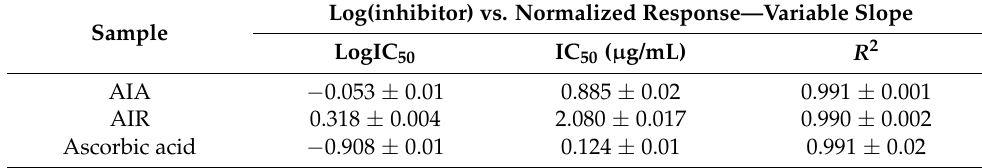
Table 1. Result summary of IC 50 and R 2